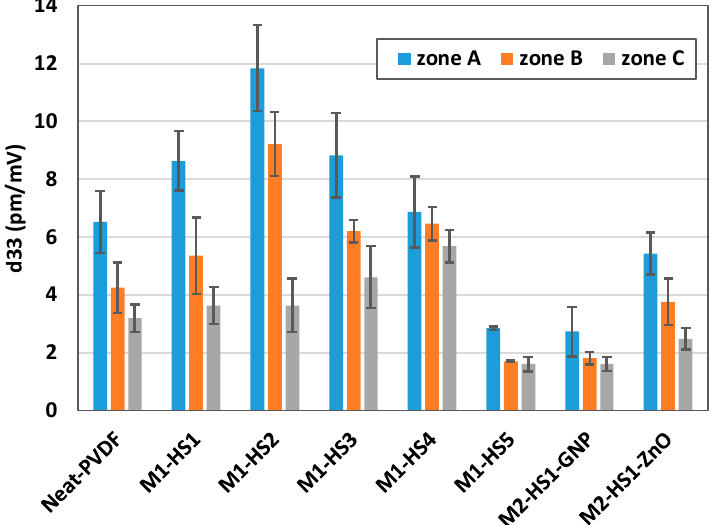
Figure 9. Measured average piezoresponse coefficient in the three zones of the produced samples, with standard deviation.